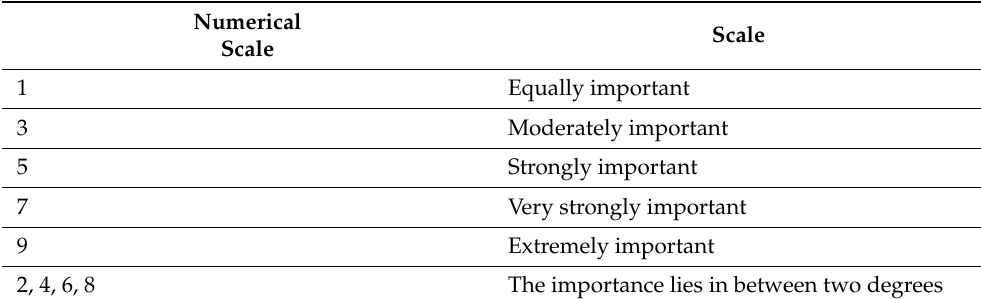
Table 2. The AHP scales for paired